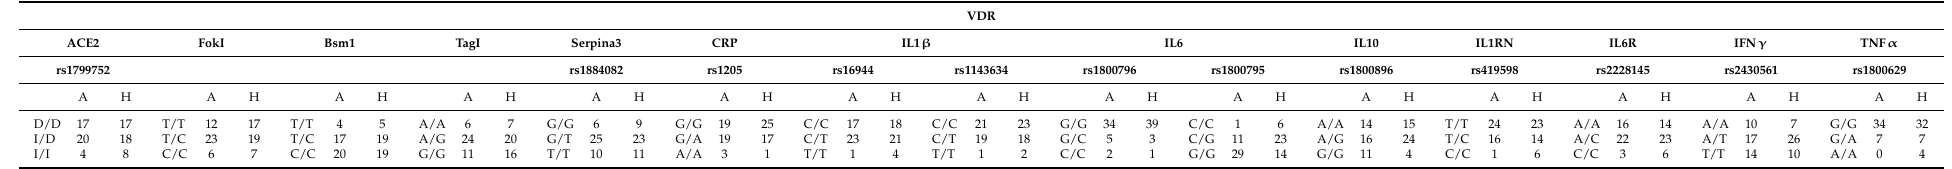
Table 2. SNPs and genotypes distribution among affected (A; n = 41) and healthy (H; n = 43) subjects; all SNPs are from in inflammatory and regulatory